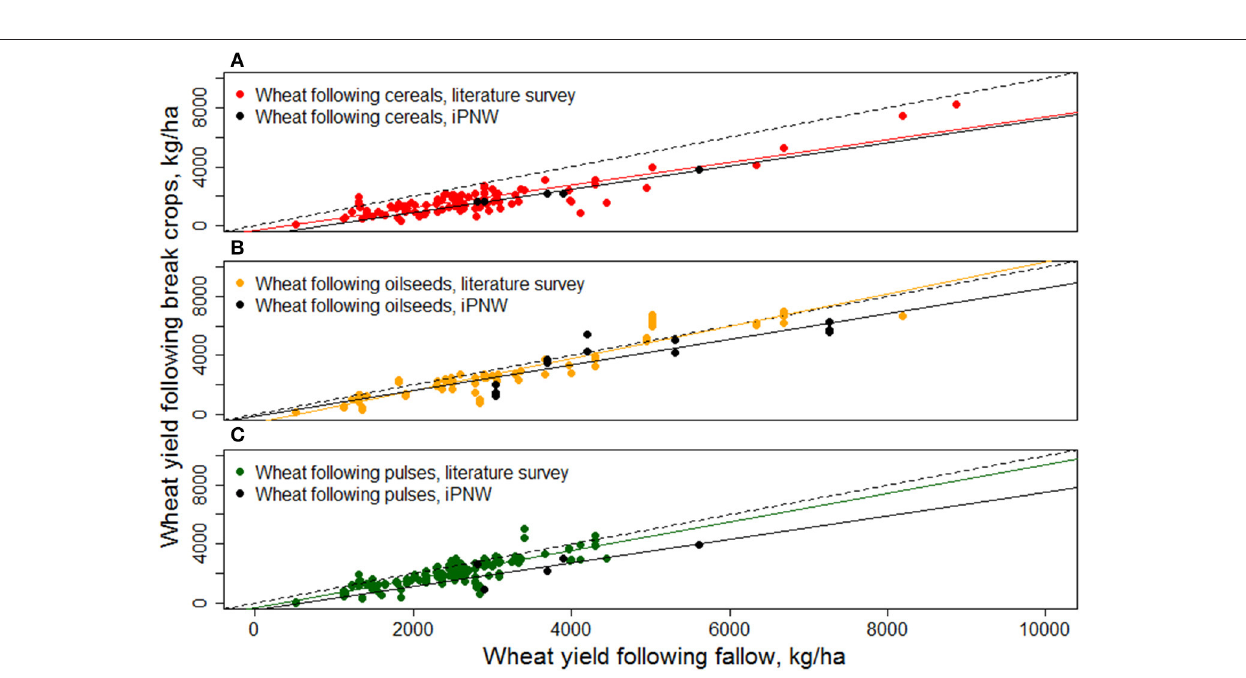
At Moro, Ritzville and Davenport, multi-year cropping